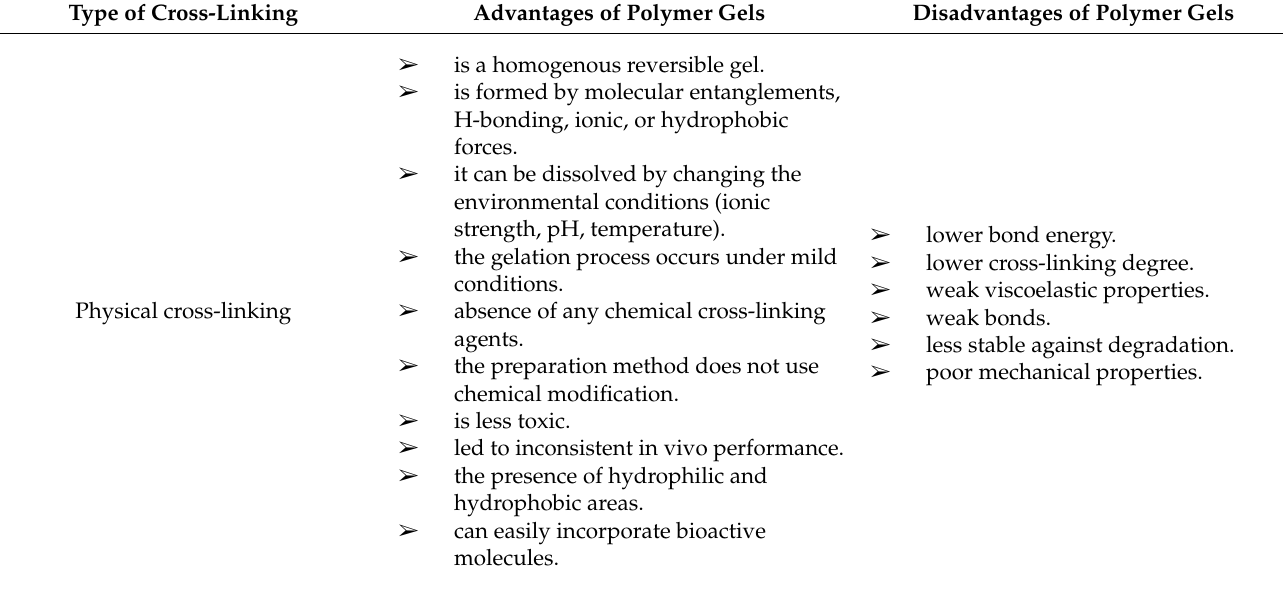
Table 1. Advantages and disadvantages of physical and chemical cross-linking. Type of Cross-Linking Advantages of Polymer Gels Disadvantages of Polymer